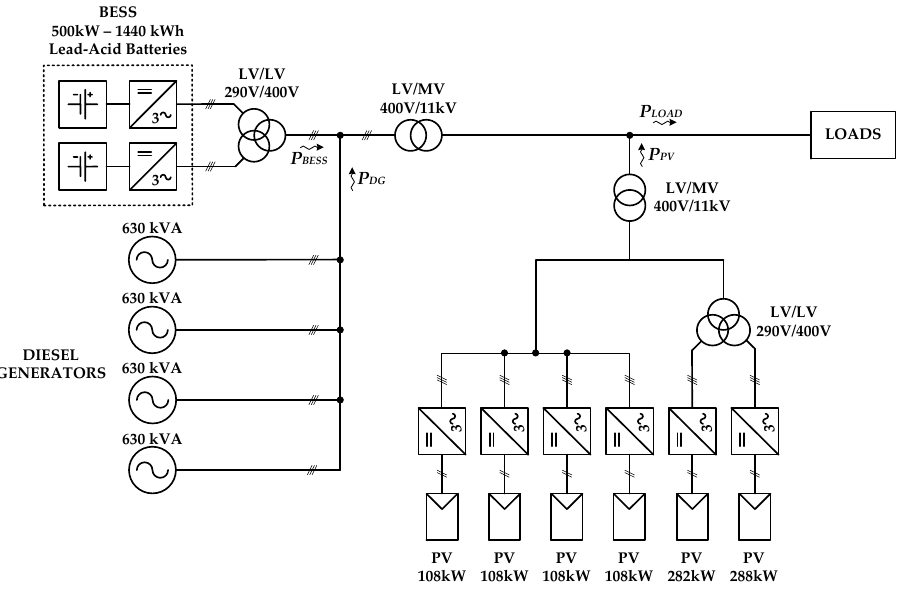
Figure 1. General diagram of the micro-grid case study.